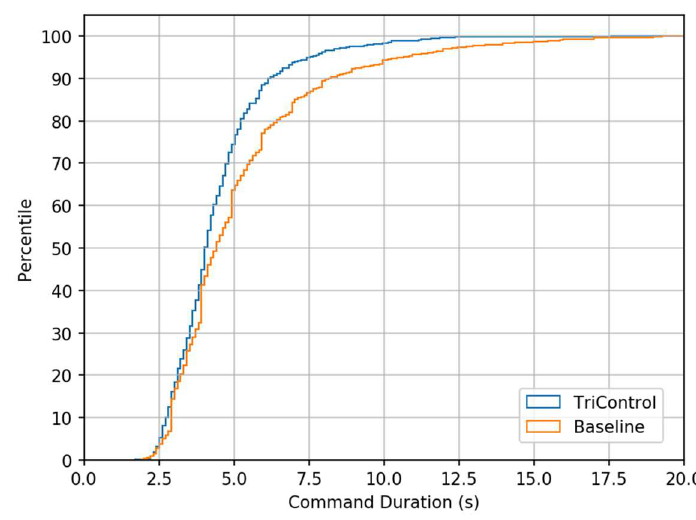
Figure 8. Cumulative distribution of Baseline vs. TriControl second half uncorrected command durations.